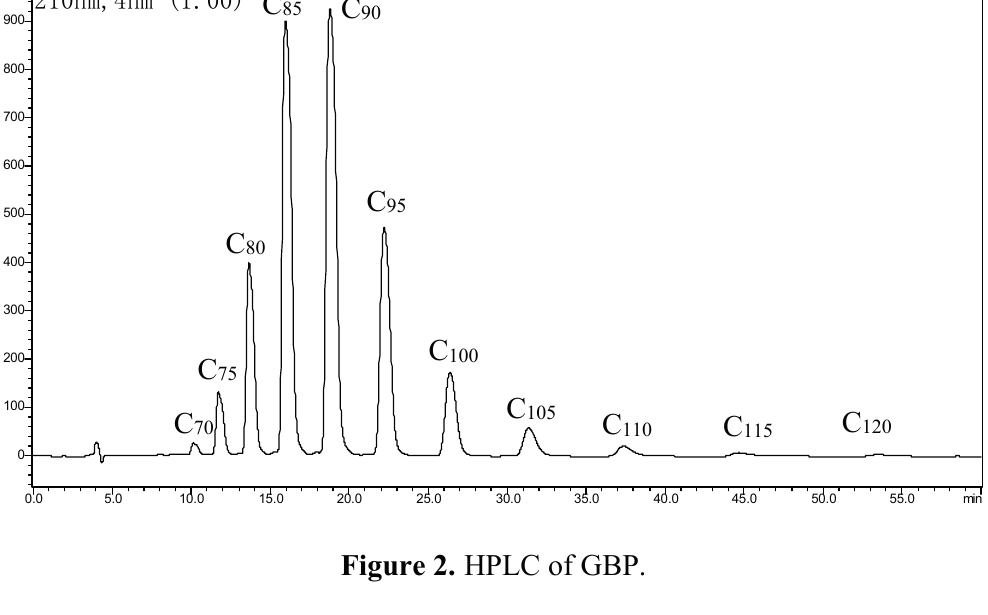
Figure 2. HPLC of